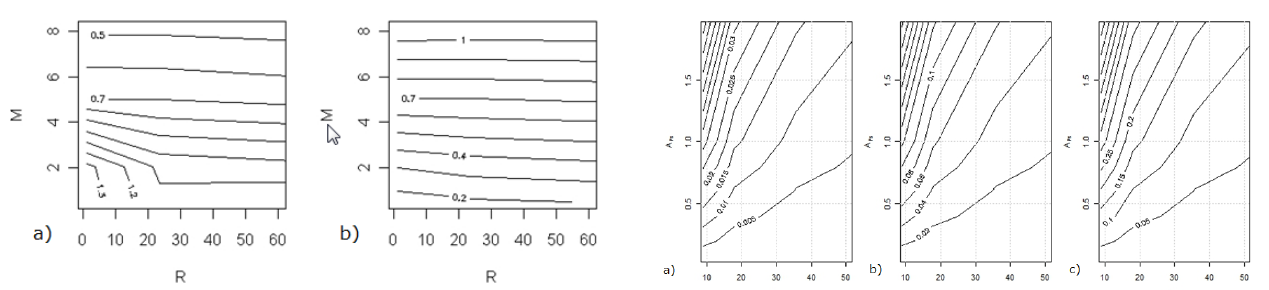
Fig. 12. Contours of change in lens thickness as a fraction of the average lens thickness as a function of frequency and amplitude. (a) M = 0 . 51, (b) M = 2 . 03, (c) M = 5 . 07. For the reference sit- uation this leads to lenses with a thickness of 4.8, 2.3 and 1.1m,